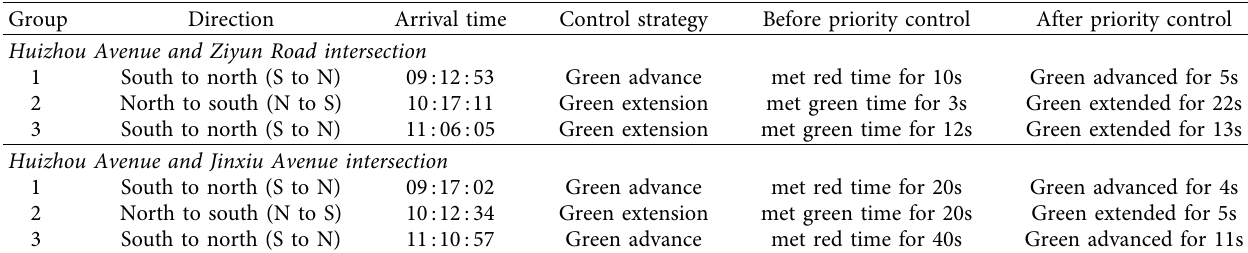
Figure 6: Analysis of total passenger delays at intersections. (a) Huizhou Avenue and Ziyun Road intersection. (b) Huizhou Avenue and Jinxiu Avenue Table 1: Part of the test data of bus signal priority control at intersections.